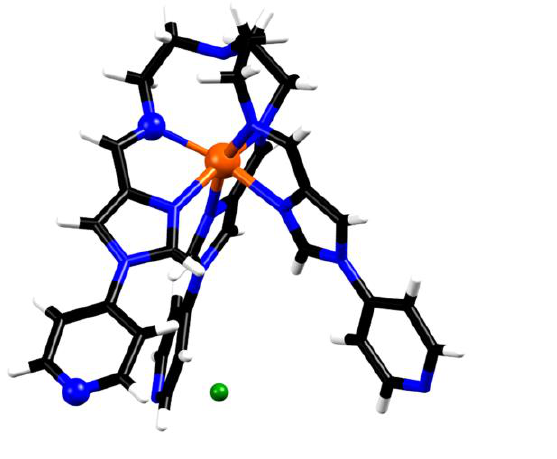
Figure 6. Representation of two selected mutually-positioned secondary group bonding axes in the metalloligand. ( a ) the intervals corresponding to the bonding direction of each of the secondary binding domains are highlighted, as defined by the coordinates of C9 and N4 in each arm of the metalloligand. ( b ) Since the bonding axes do not intersect, they are translated such that the reference C atoms in both ligand arms share the same point. The angle between axes can then be calculated.